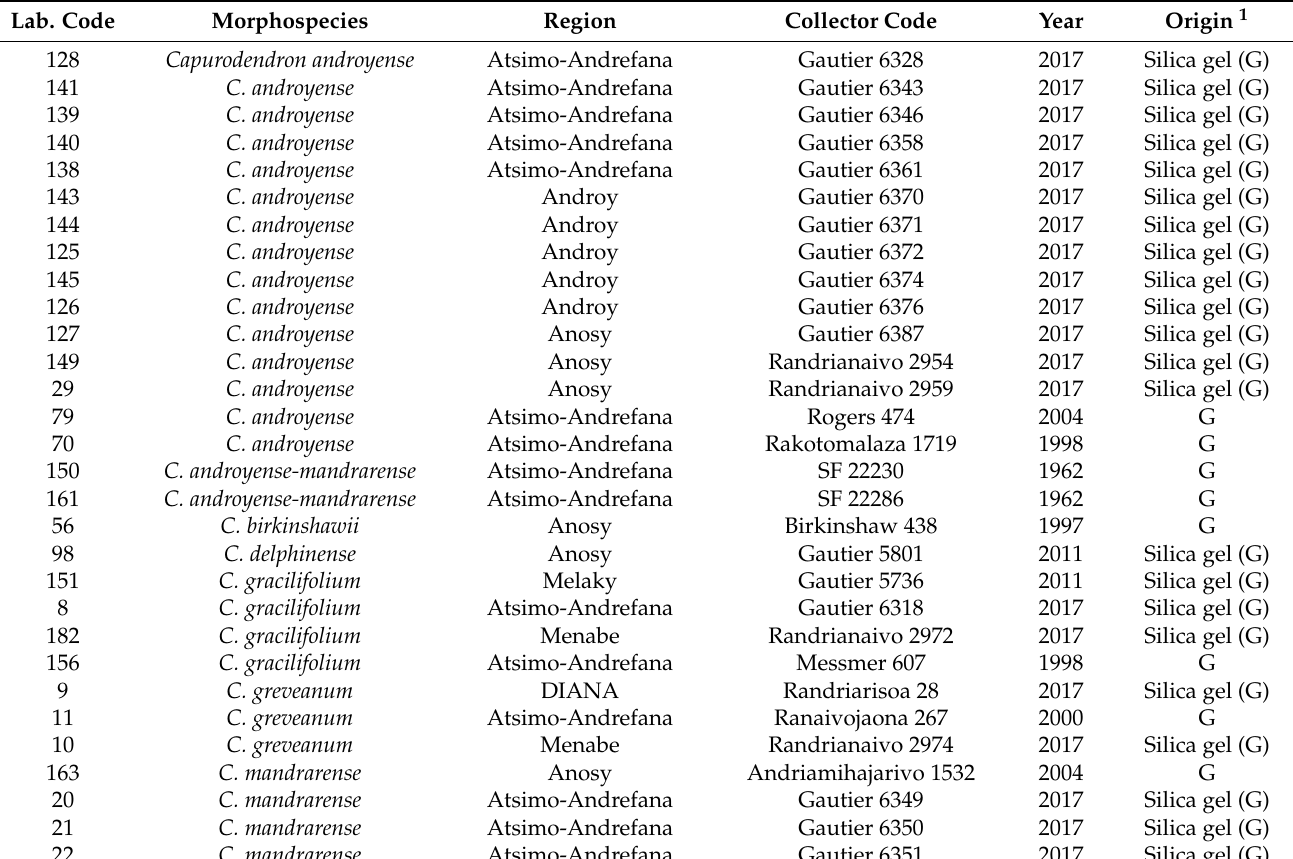
Table 2. Information on the specimens used. Original identification, followed by collector’s name and number, collection year and sample